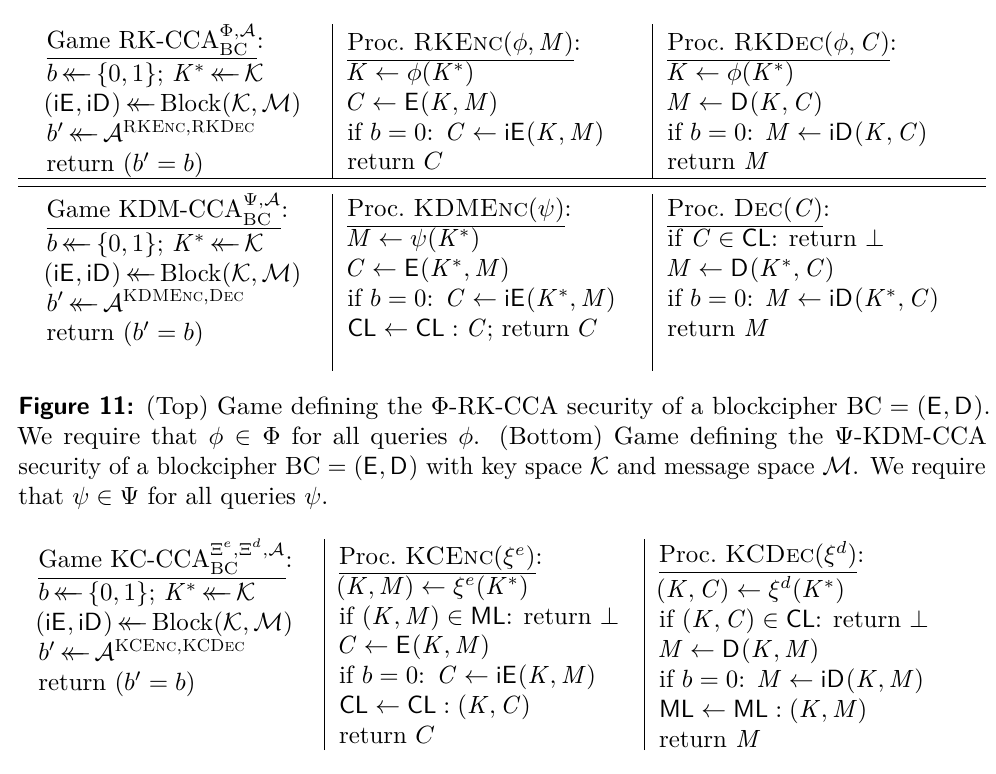
Figure 12: Game for (Ξ e , Ξ d )-KC-CCA security of a blockcipher BC = ( E , D ) from Sec.